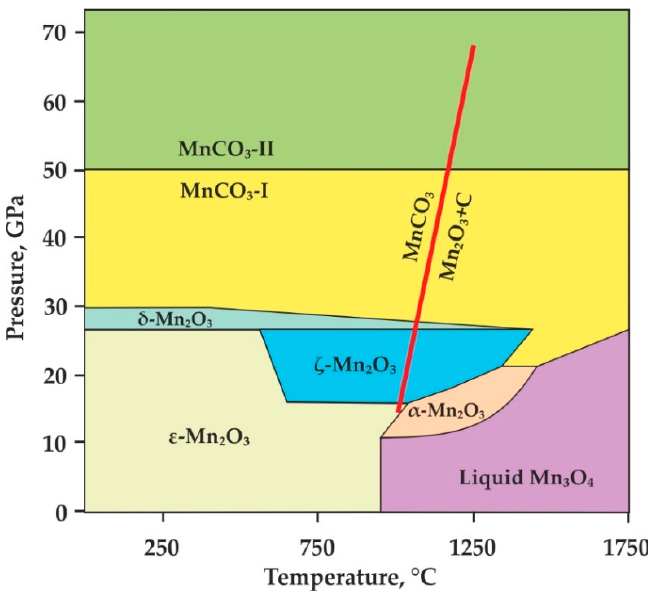
Figure 1. Pressure ( P )-temperature ( T ) diagram for MnCO 3 and Mn 2 O 3 stability after [12,28]. MnCO 3 -I-rhombohedral structure (rhodochrosite), MnCO 3 -II-triclinic structure high-pressure polymorph.